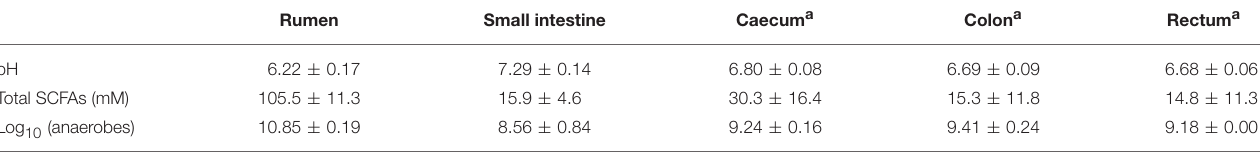
TABLE 2 | Anaerobic bacteria counts, pH values and SCFA concentrations in the digestive contents before incubation (T0). Rumen Small